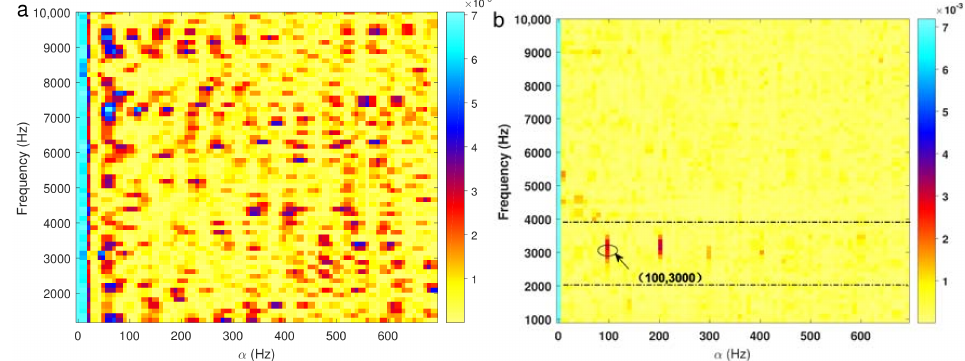
Figure 9. The MID SCoh ∆ of the simulated vibration signal (the noise variance is 0.7) ( a ) and the f decomposed BLIMF2 using VMD ( b